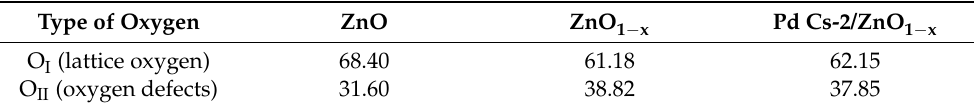
Figure 8. O 1s spectra of ( a ) ZnO, ( b ) ZnO 1 − x and ( c ) Pd Cs-2/ZnO 1 − x . Table 2. Corresponding Percentage of O 1s Peaks among ZnO, ZnO 1 − x and Pd Cs-2/ZnO 1 − x , respectively (%).